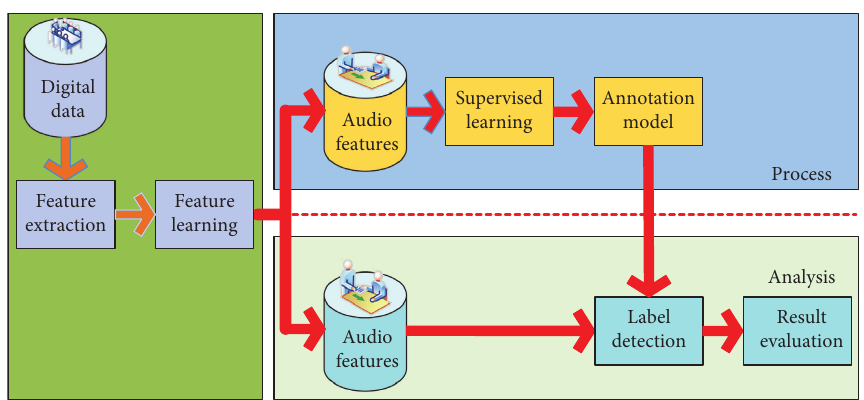
Figure 8: Feature extraction simulation results obtained after data